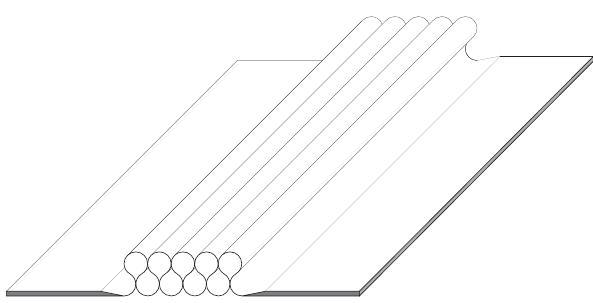
Figure 12: Long plate or shallow shell with flexible-skin section